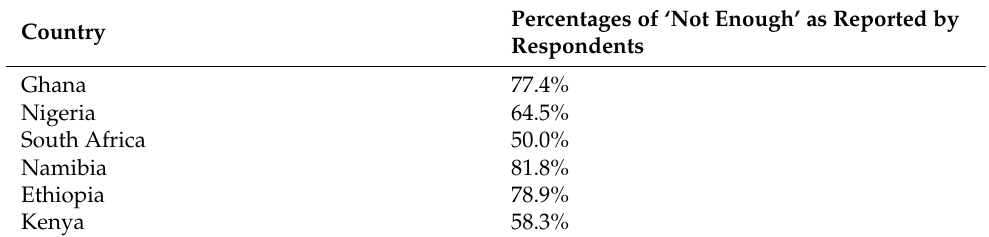
Percentages of ‘Not Enough’ as Reported by Respondents